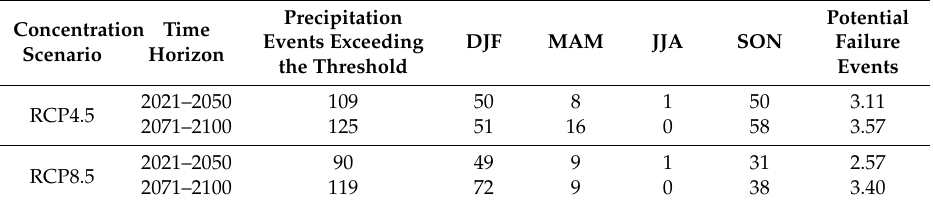
Table 2. For both RCPs (first column) and time horizons (second), the number of potential events estimated using the De Vita & Piscopo [64] threshold (third), seasonal distribution (fourth to seventh), and potential failure events obtained using the “likelihood of success” estimated for the observed data from 1983 to